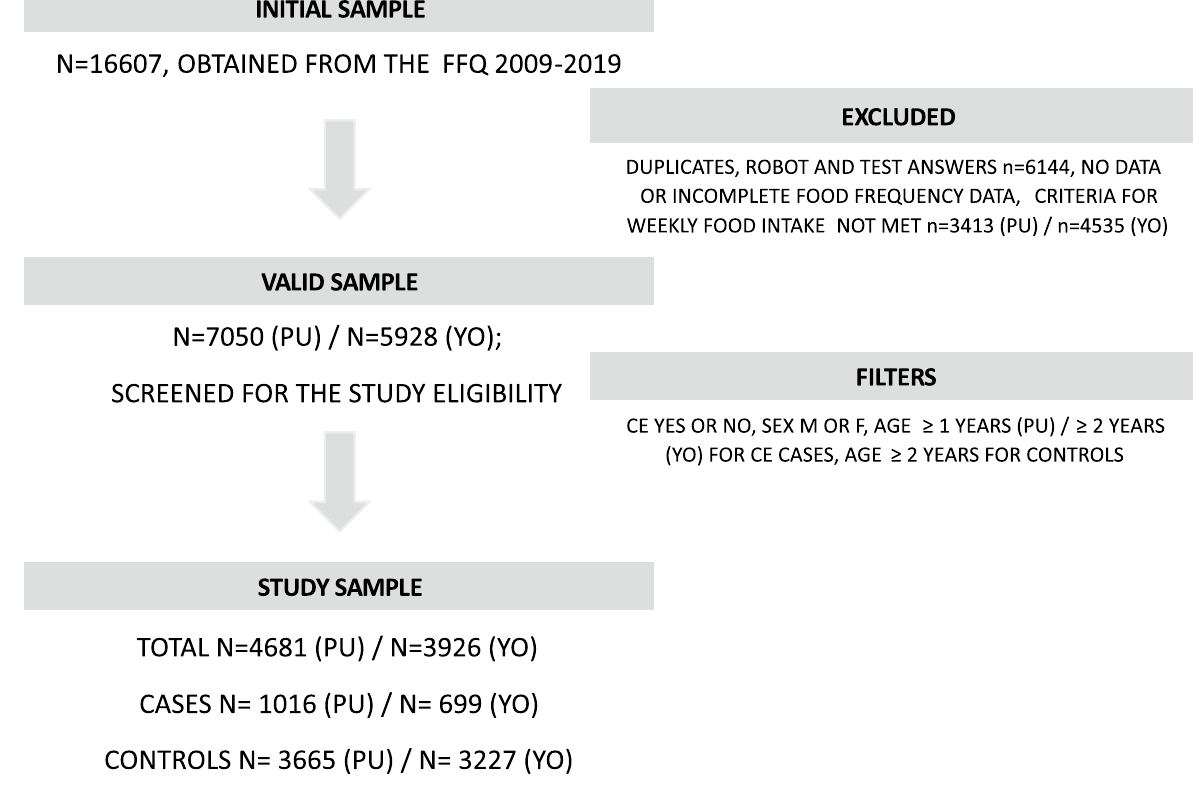
Figure 1. Flow chart of the study sample. PU = puppyhood, YO = adolescent, CE = owner-reported chronic enteropathy, M = male, F = female, FFQ = food frequency